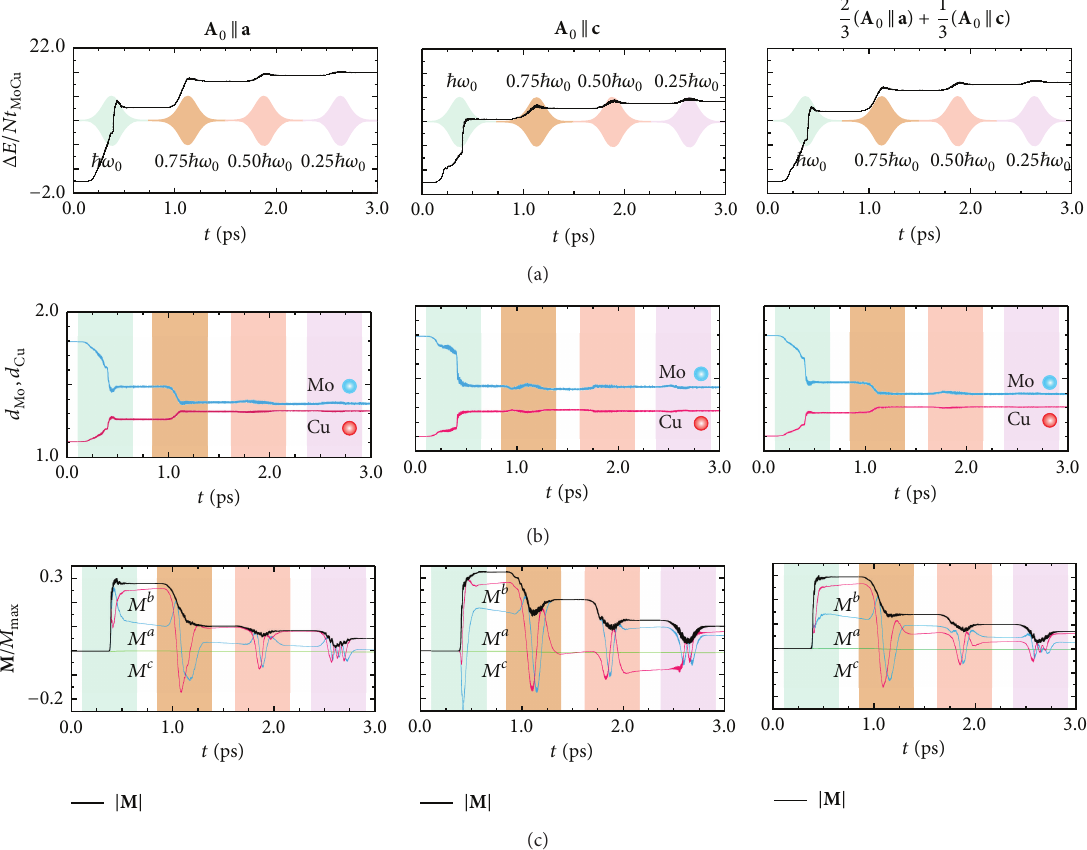
Figure 6: Manipulation of the magnetization by applying successive pump laser pulses in the form of (15) with A 0 ‖ a (the left panels) and ‖ c (the middle panels). (a) An absorbed photon energy and an envelope of the applied vector potential. (b) Averaged electron densities A 0 on Mo and Cu sites. (c) A magnetization. The two-to-one mixtures of the results in the cases of A 0 ‖ a and A 0 ‖ c (the right panels) are also presented in an attempt to reproduce powder-sample observations [26].